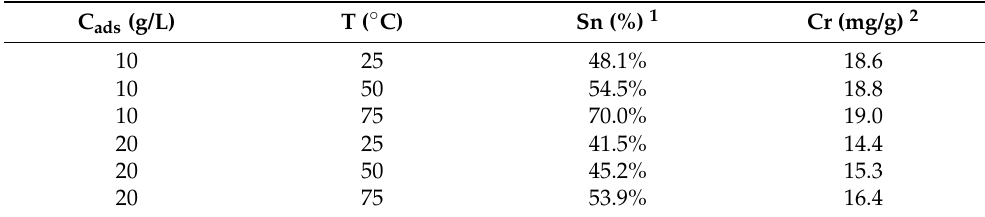
Table 6. Dissolved Sn and Cr in relation to spent adsorbent’s concentration for different temperatures (acid: HCl, T: 25 ◦ C, t = 30